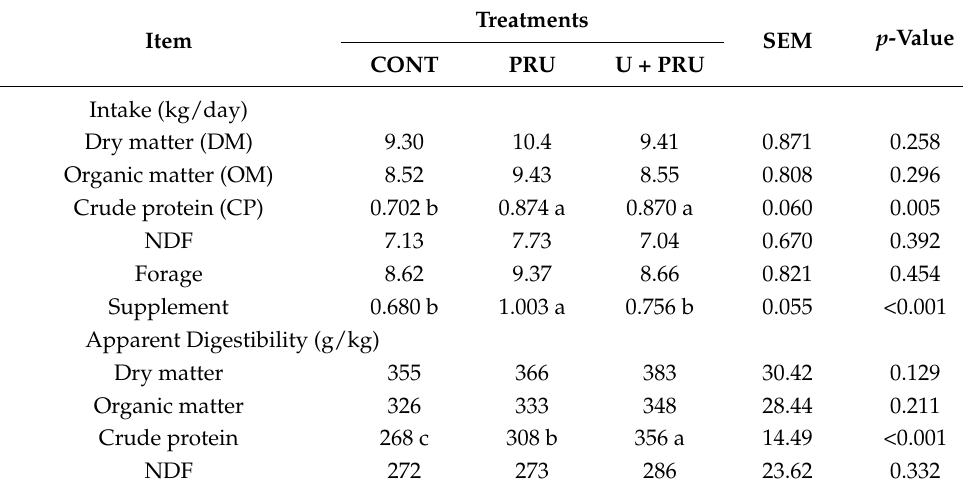
Table 3. Intake and apparent total-tract digestibility in Nellore steers, supplemented with post- ruminal urea and conventional urea during the dry